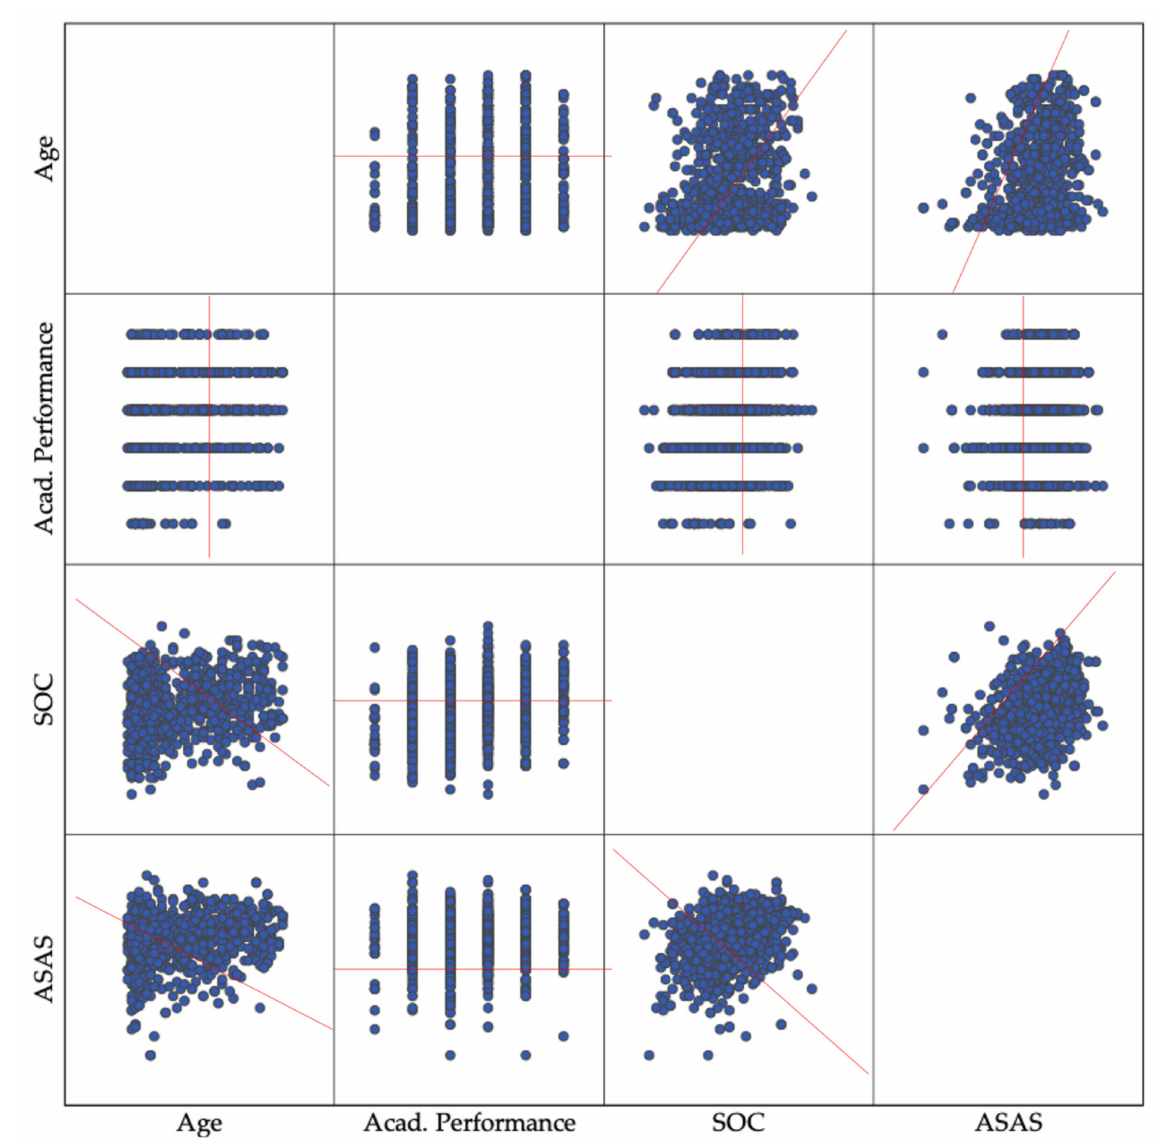
Figure 1. Graphical correlations between the SOC-13 and ASAS total score values per participant, also crossing their scores with participants’ age and self-reported academic performance (n = 921).